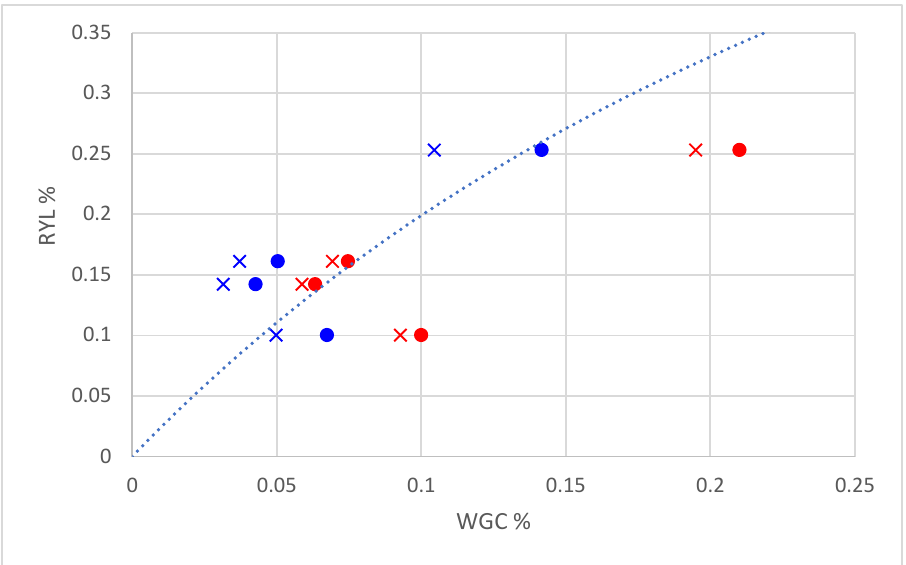
Figure 4. Curve 1 (RYL = 2.5 WGC/1 + 2.57 WGC = C1) shows the relationship between weed green cover (WGC) and relative yield loss (RYL). Red symbols = method 1 (M1), blue symbols = method 2 (M2), dots = 10 m and crosses = 20 m.